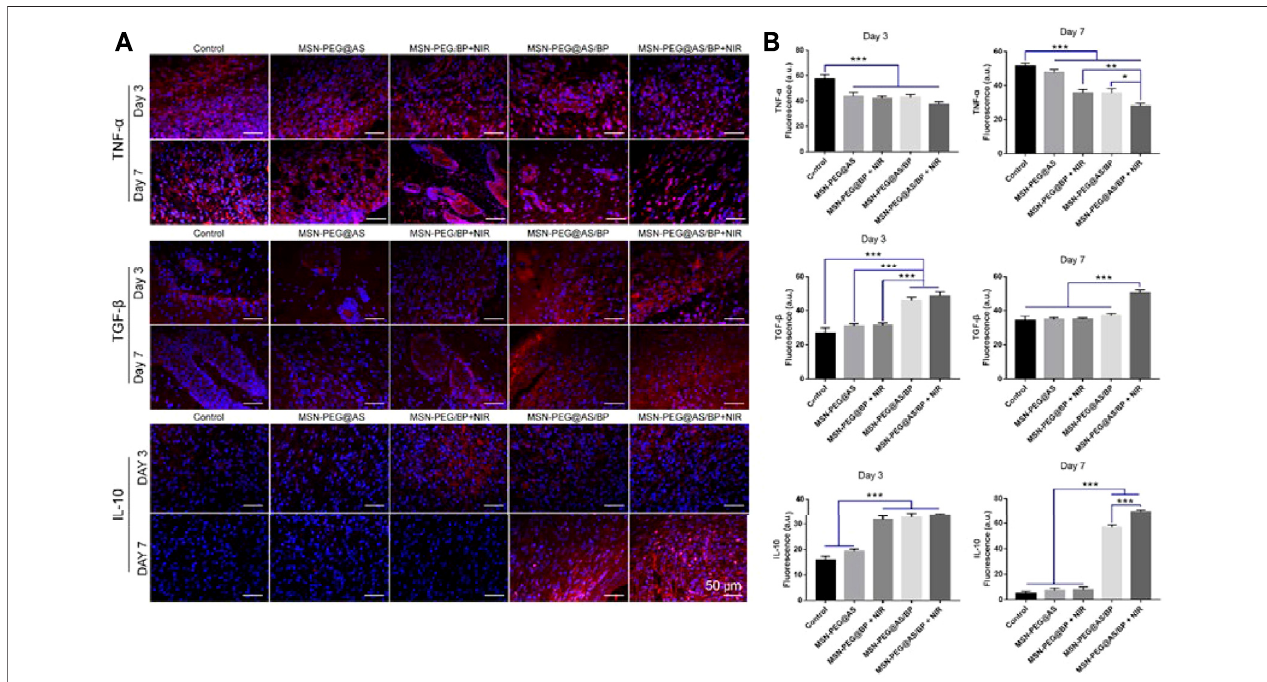
FIGURE 8 | (A) Immuno fl uorescence staining of TNF- α , TGF- β , and IL-10 in the wounds at Day 3 and Day 7. (B) Quantitative analysis of Immuno fl uorescence staining of TNF- α , TGF- β , and IL-10 in the wounds at Day 3 and Day 7.